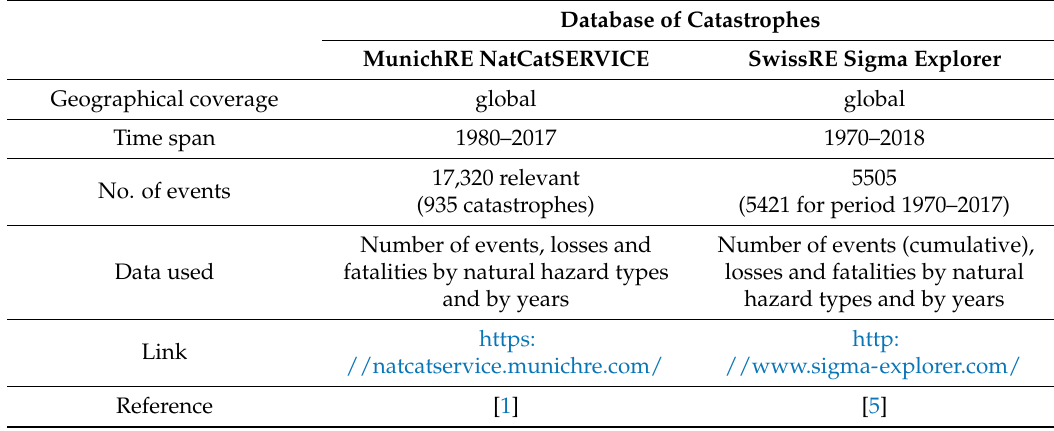
Table 2. Basic characteristics of two databases of natural disasters used in this